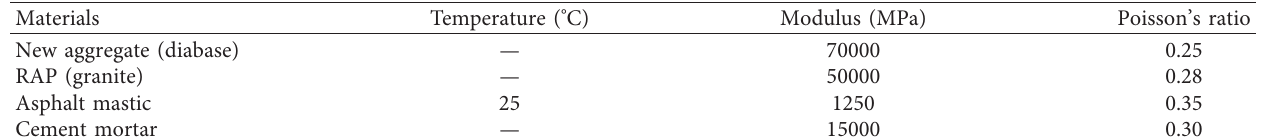
Table 5: Parameters of warm-mixed reclaimed semiflexible pavement.